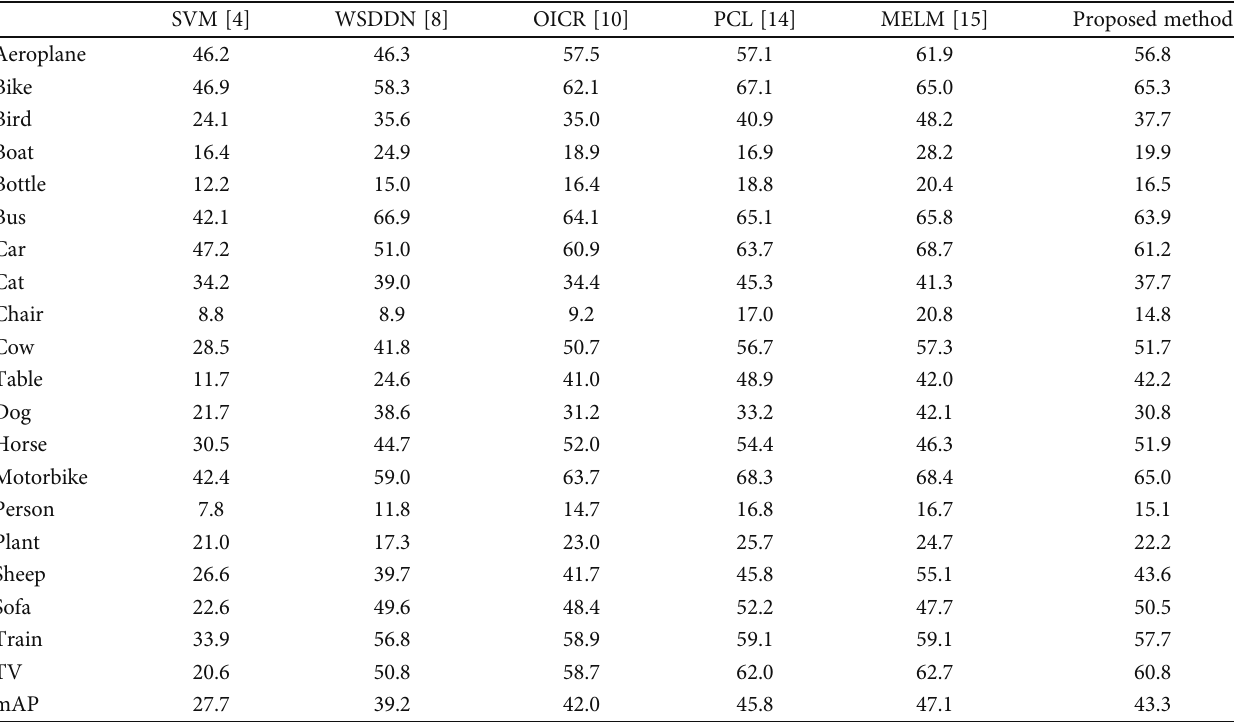
Table 2: Object detection results of di ff erent methods on PASCAL VOC 2007 dataset.